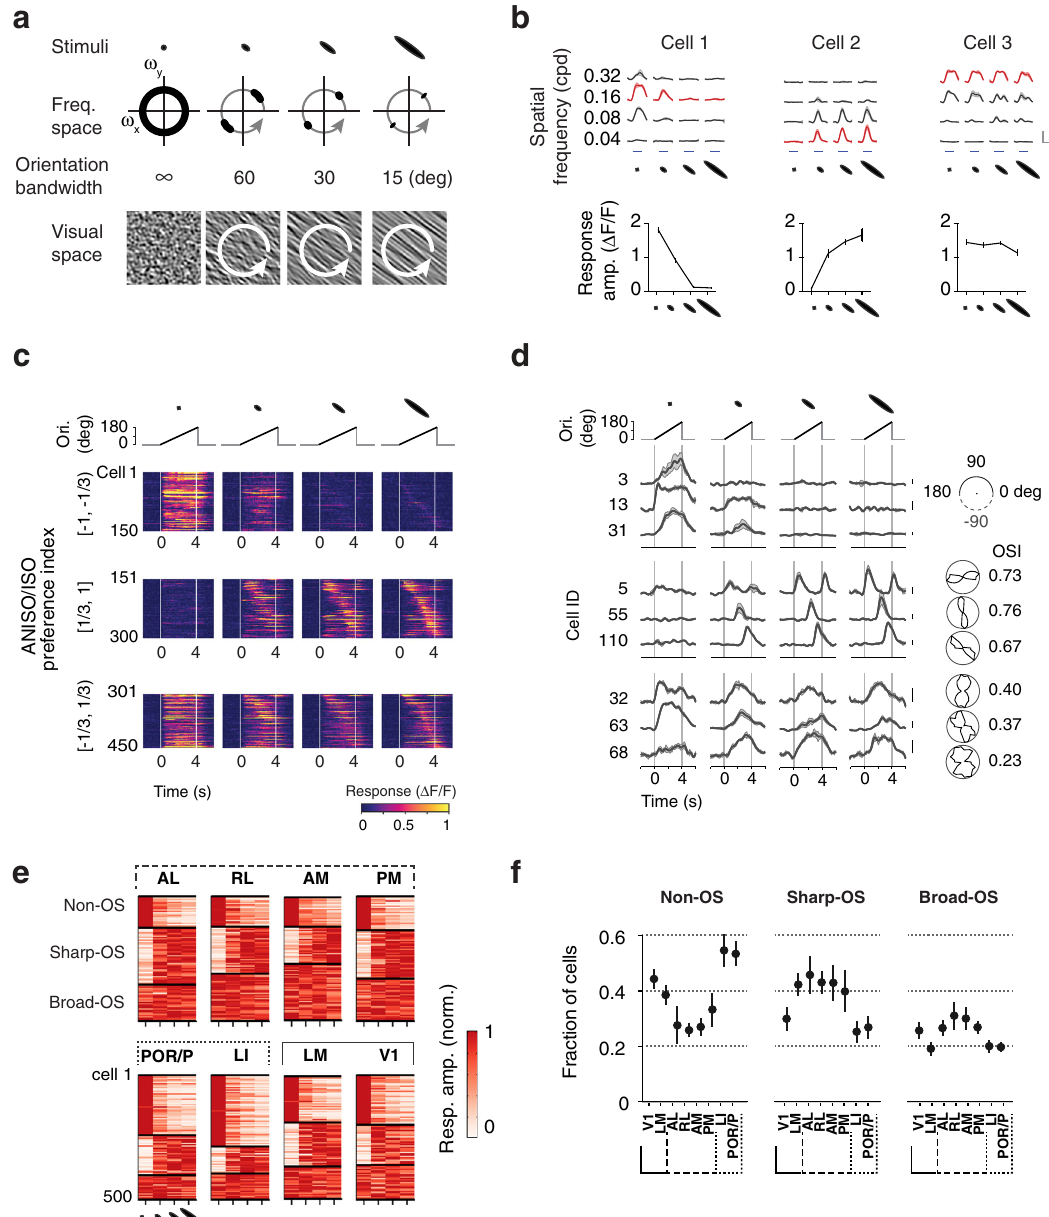
Fig. 6 Discrete response types underlie divergent representations of oriented and non-oriented stimuli. a Stimuli to investigate the tuning for spatial elongation in visual cortical populations. Varying the orientation bandwidth (top) changes the correlation of orientation over space and hence the elongation of visual patterns (bottom). We recorded responses to a full matrix of stimuli comprising four center spatial frequencies (orientation bandwidth: in fi nite, 60, 30, 15 deg FWHM) and four orientation bandwidth (center spatial frequency: 0.04, 0.08, 0.16, 0.32 cpd; center temporal frequency 2 Hz) (dataset 3). The orientation of the anisotropic stimuli varied over time within each stimulus epoch (arrows, 45 deg/s). b Example responses illustrating the types of responses observed: isotropic and anisotropic preferring responses (cell 1 and 2) and elongation invariant responses (cell 3). Same cells as in Fig. 1d. The tuning curves (bottom, n = 4 trials) were measured at the neuron ’ s peak spatial frequency (top, red traces). Scale bar: 1 Δ F/F and 10 s. Mean ± s.e.m. c Heat maps showing example time courses of population responses to stimuli of four distinct orientation bandwidth. Each block shows responses of 150 randomly-selected cells simultaneously-imaged in V1, grouped by ANISO/ISO preference indices (dataset 3, ranges [ − 1, − 1/3], [1/3,1], and [-1/3,1/ 3]), calculated from the responses to the stimuli with in fi nite and 15-deg orientation bandwidth. Within blocks, rows (time courses) are sorted according to time to response peak, measured from the 15-deg orientation bandwidth condition (rightmost column). d Calcium traces (left) and polar plots (right) of a random subset of neurons in c . Scale bar: 0.3 Δ F/F. e Color-coded maps of random samples of elongation tuning curves showing the distinct proportions of tuning types in visual areas (500 neurons per area). The three clusters obtained with ward linkage clustering correspond to non-OS, sharp-OS, and broad- OS (OS: orientation selective). In these plots, each row corresponds to one neuron, and each column corresponds to one stimulus condition. Note the uneven representations of the clusters across visual areas. f Fraction of cells belonging to each cluster in each visual area. Means and s.e.m. of the fractions were estimated using hierarchical bootstrapping ( n = 10 subsampling, 500 random neurons per area per subsampling).